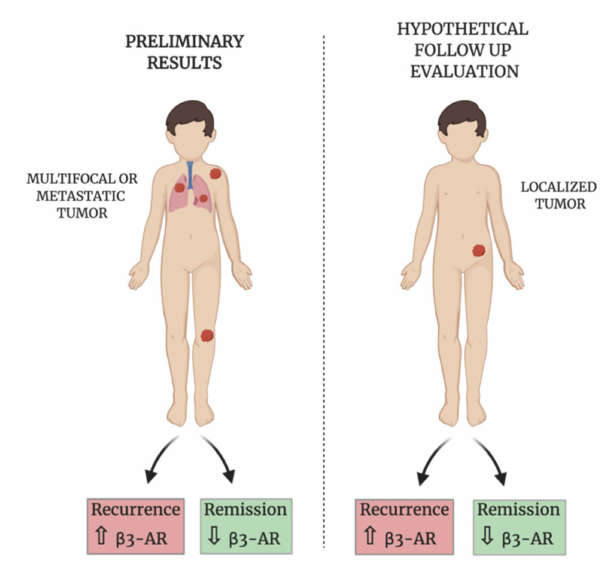
Figure 7. Schematic representation of the preliminary results on metastatic patients (left) and the suggested evaluation during the follow-up even for localized patients